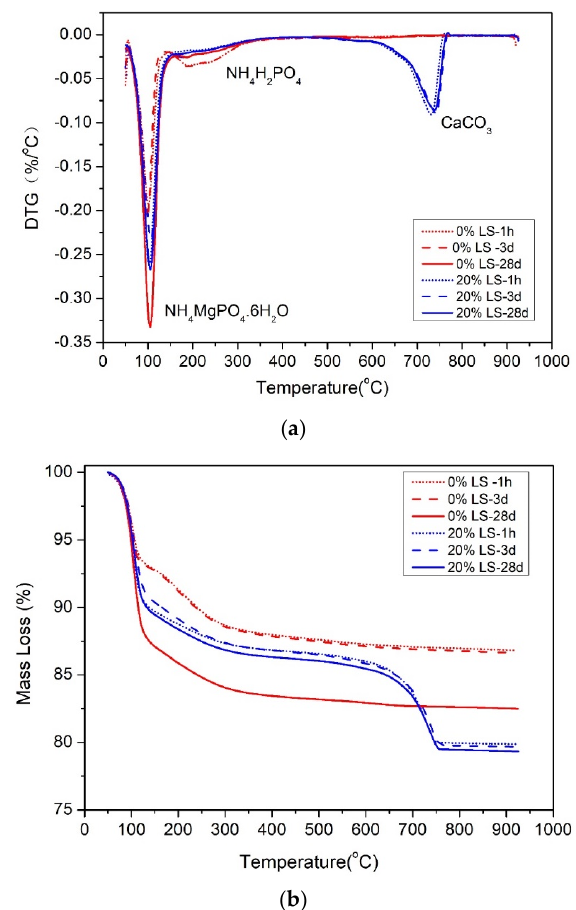
Figure 8. Thermogravimetric (TGA) analysis on MAPC mortar samples with 0% and 20% limestone fines at different curing ages of 1 h, 3 days, and 28 days, ( a ) differential thermogravimetry (DTG) curves; ( b ) mass loss curves.